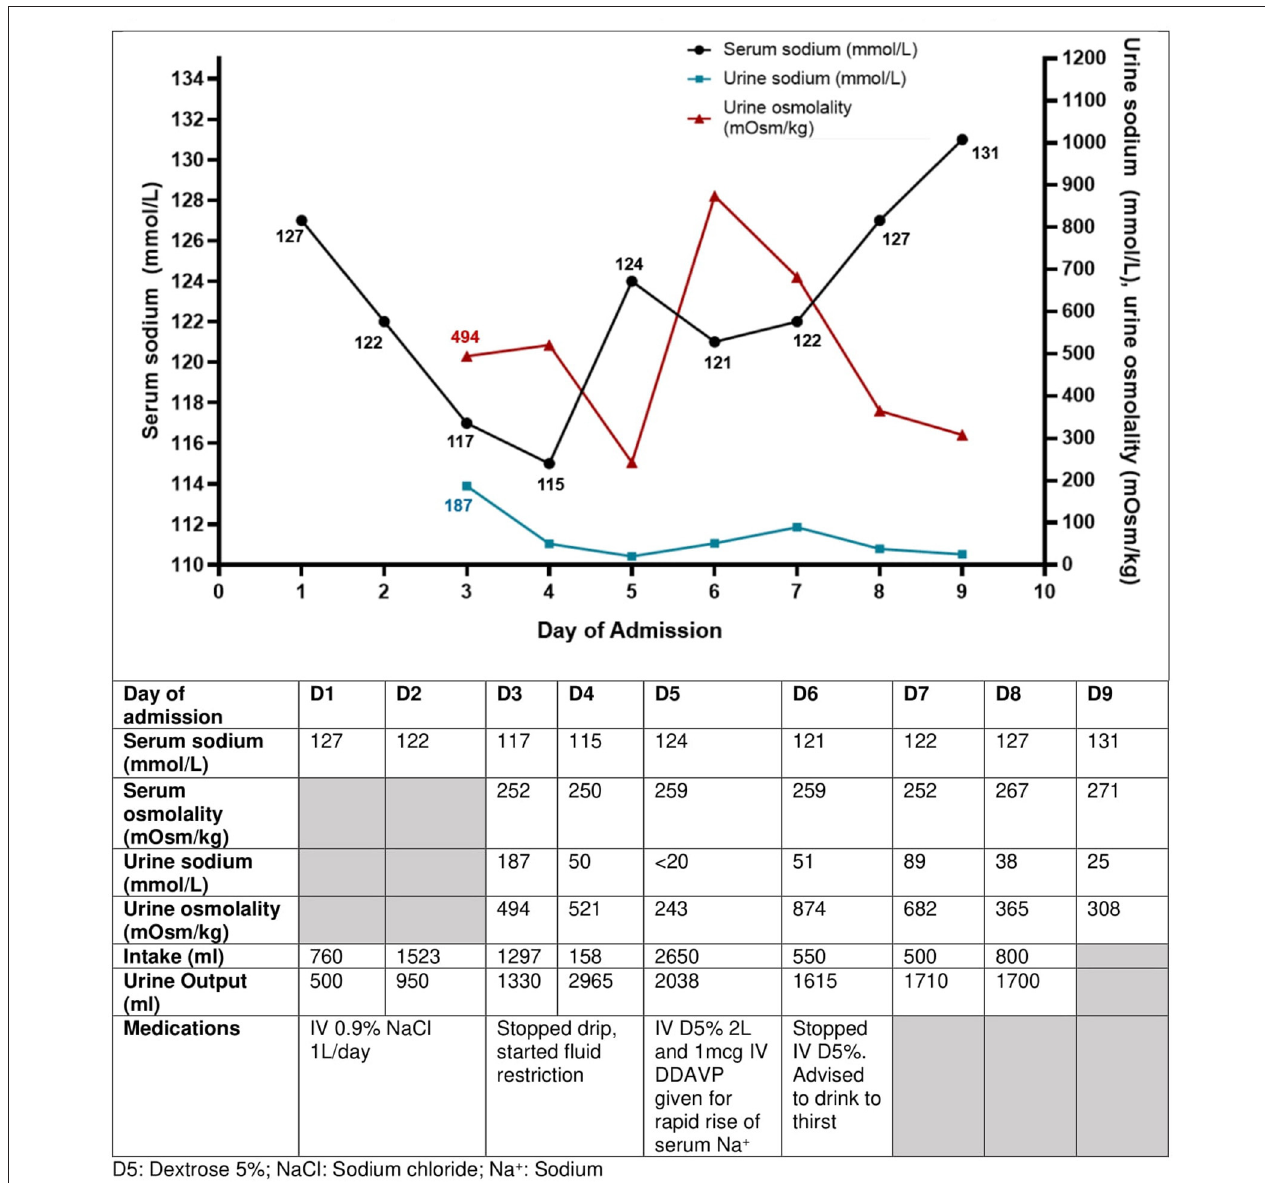
FIGURE 2 | Trend of serum sodium concentrations, urine sodium concentrations, and urine osmolality with the interventions taken in Case 2 with recurrent SIADH. The current SIADH episode illustrated here was caused by dyspepsia from gastritis. His urine sodium concentration was elevated at 187 mmol/L initially and reduced as his hyponatremia due to SIADH improved. The urine biochemistry was performed on urinary spot samples.